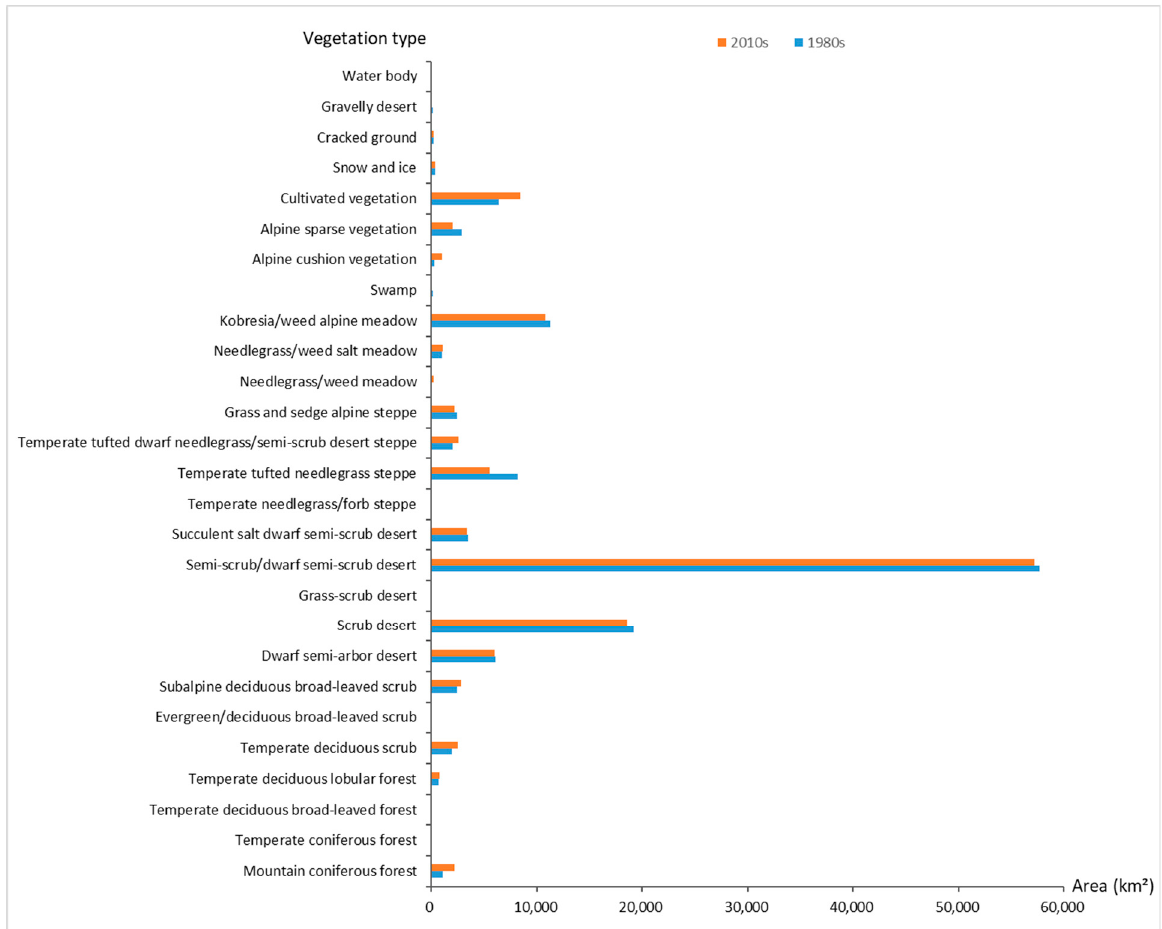
Figure 3. Vegetation change in Heihe River Basin between the 1980s and the 2010s.